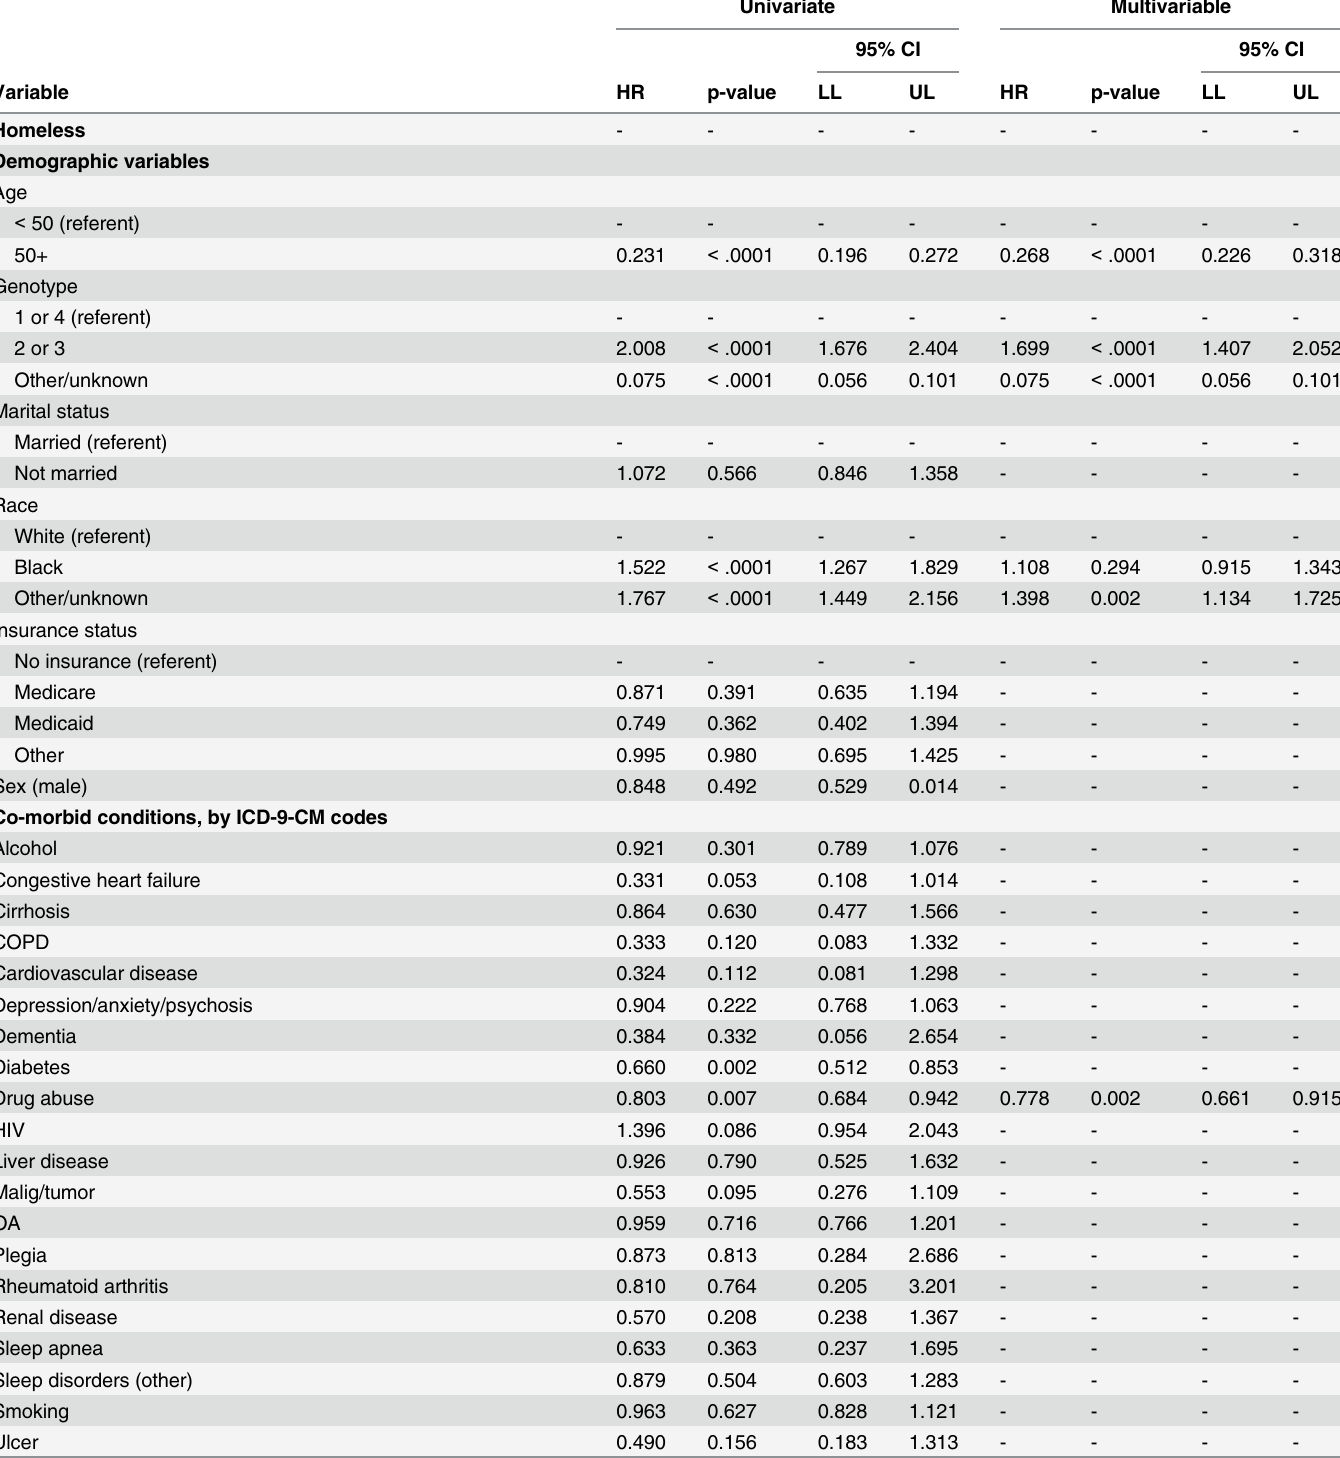
Table 3. Results of univariate and multivariable Cox Proportional Hazards regression models of initiation of HCV treatment in 11,082 U.S. Veterans with evidence of homelessness and with chronic hepatitis C (HCV) diagnosis who were treatment na ï ve for HCV, 2004 –